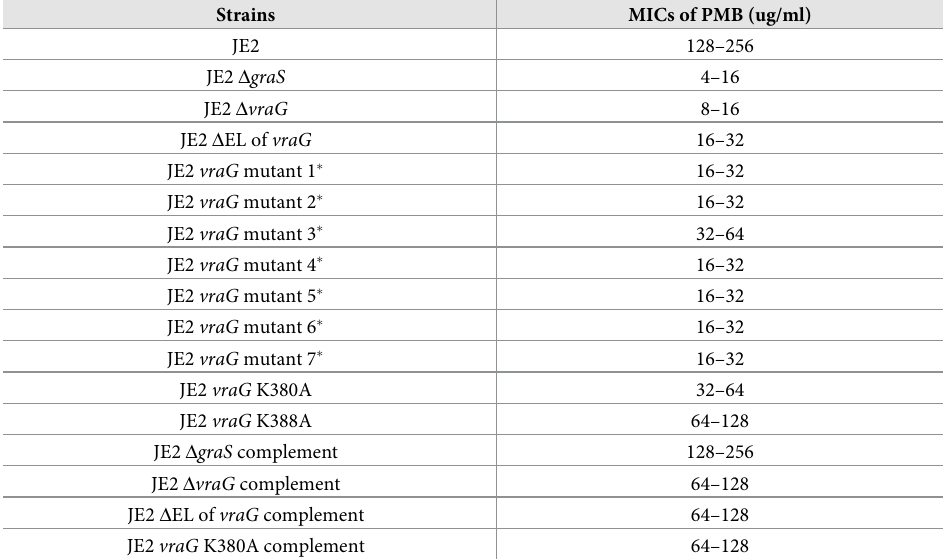
Table 2. MICs of PMB for JE2 mutants.